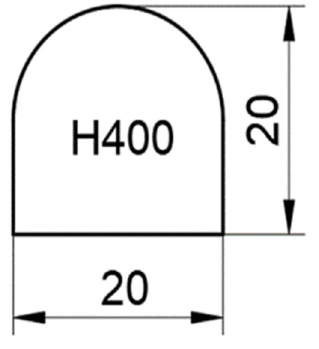
Figure 3. Piece dimensions (mm).